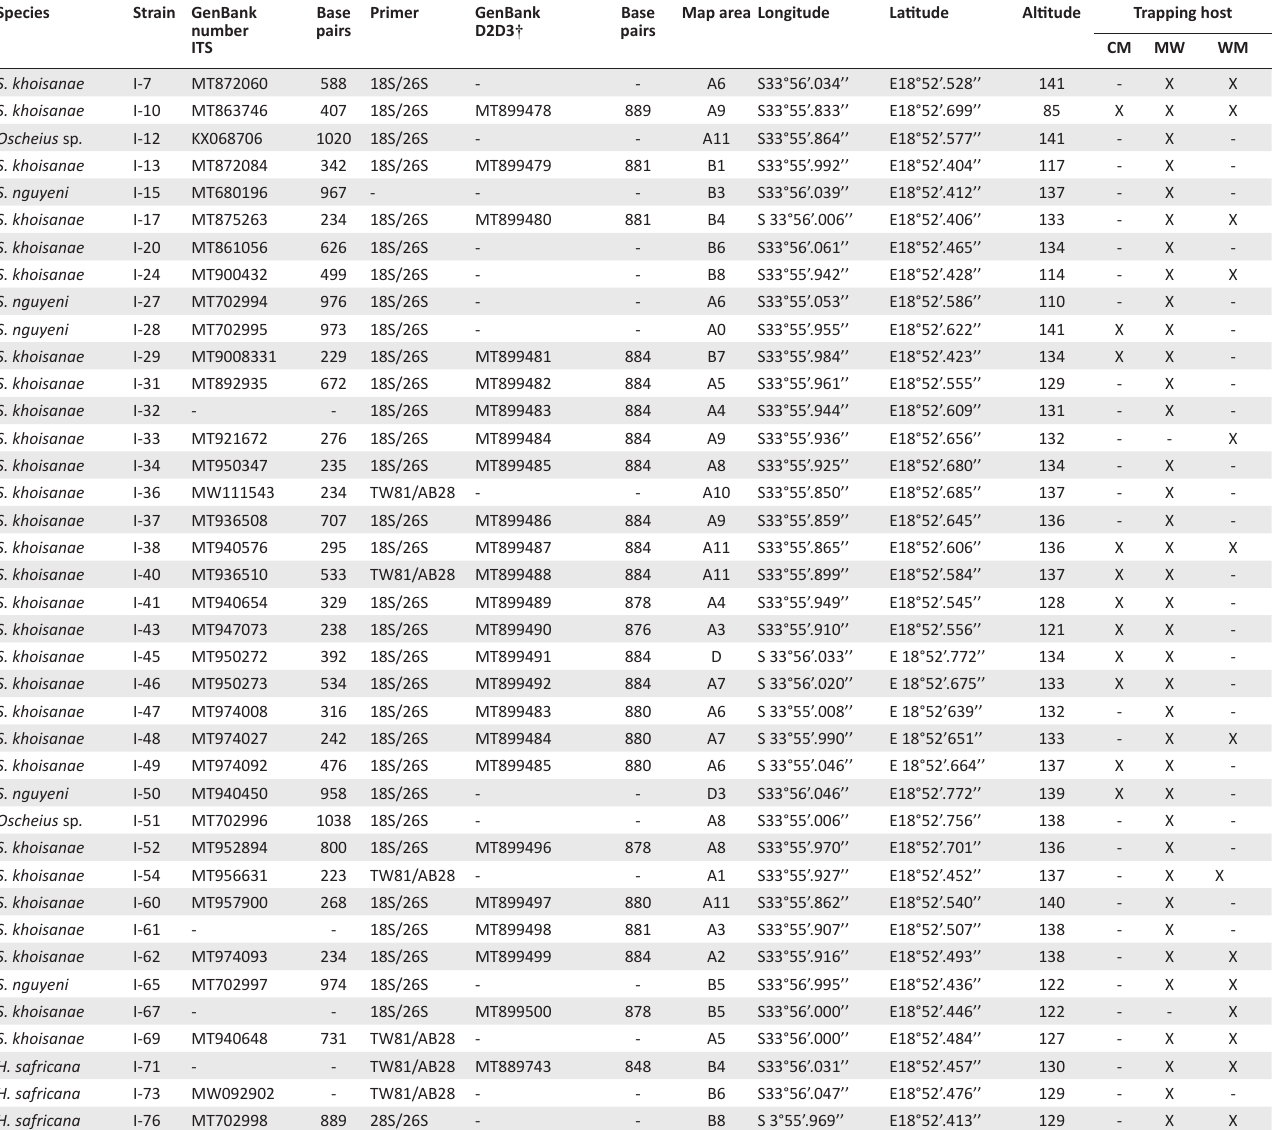
TABLE 1: Identification of entomopathogenic nematodes ( Steinernema , Heterorhabditis and Oscheius ) isolated from soil collected at the JS Marais Nature Reserve. Species Strain GenBank